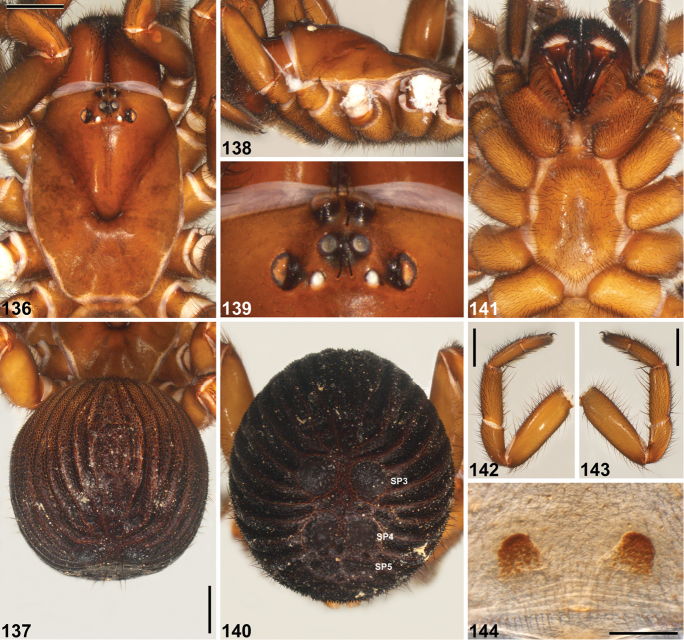

Idiosoma
dandaragan sp. n., female (WAM T127017) from NE. of New Norcia (Western Australia; AVW). 136–137 Carapace and abdomen, dorsal view 138 Carapace, lateral view 139 Eyes, dorsal view 140 Abdomen, posterior view 141 Sternum, ventral view 142 Leg I, prolateral view 143 Leg I, retrolateral view 144 Spermathecae, dorsal view. Scale bars 2.0 (136–137, 142–143), 0.5 (144). SP3–5 = sigilla pairs 3–5.